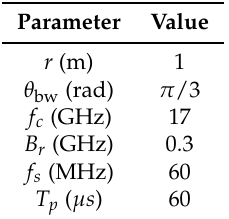
Table 3. Real data parameters.